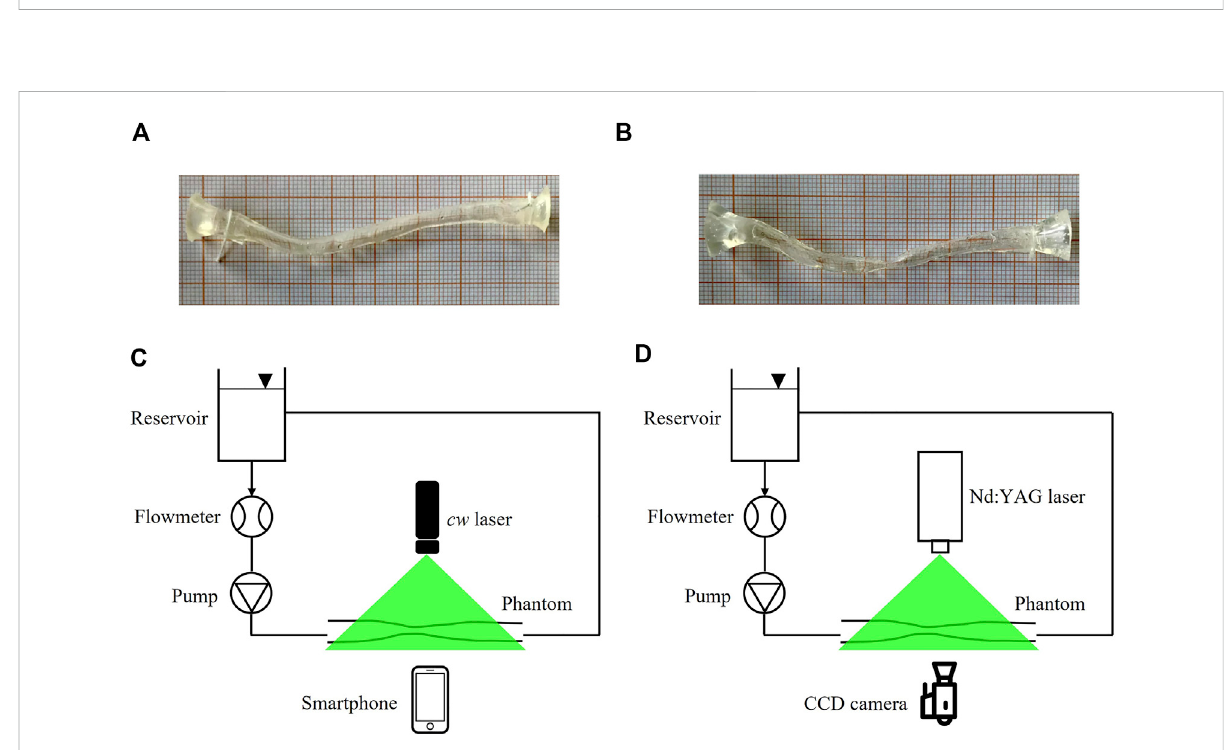
FIGURE 2 (A , B) picturesofthehealthyLAD (A) andstenosedLAD (B) phantoms,scale1:1. (C , D) experimentalset-upforsmart-PIV (C) andconventionalPIV (D) experiments. cw : continuous wave; CCD: charge-coupled